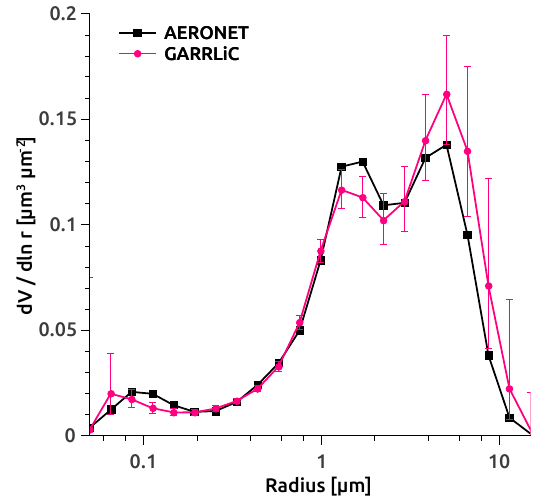
Figure 4. Volume size distribution retrieved by GARRLiC (pink) and AERONET (black) on 30 March 2014 (07:40UTC) in Lille (AOD 440nm ≈ 0 . 52 ; α ≈ 0 . 27 for 440/870nm).